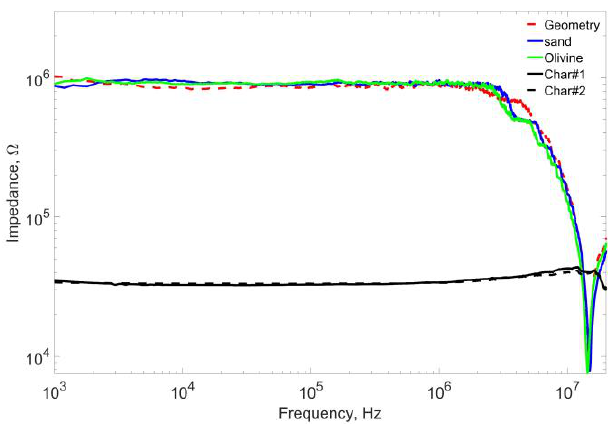
Figure 7. Surface impedance of the chosen samples of the DBD bed materials measured at ambient temperature.